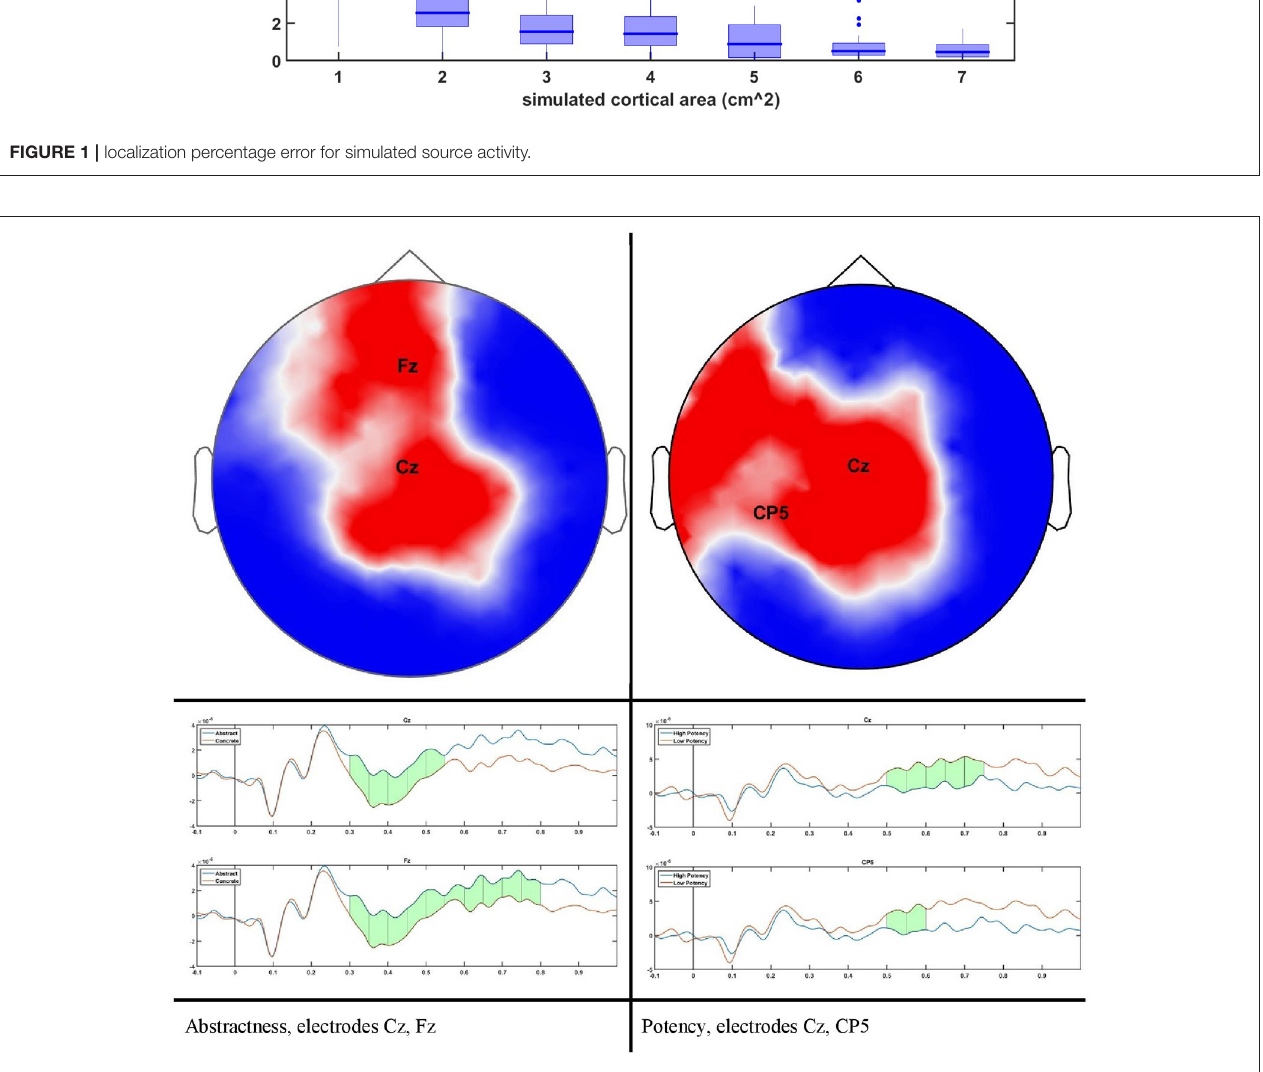
FIGURE 2 | scalp plot for significant differences and time course for two sample electrodes as indicated in scalp